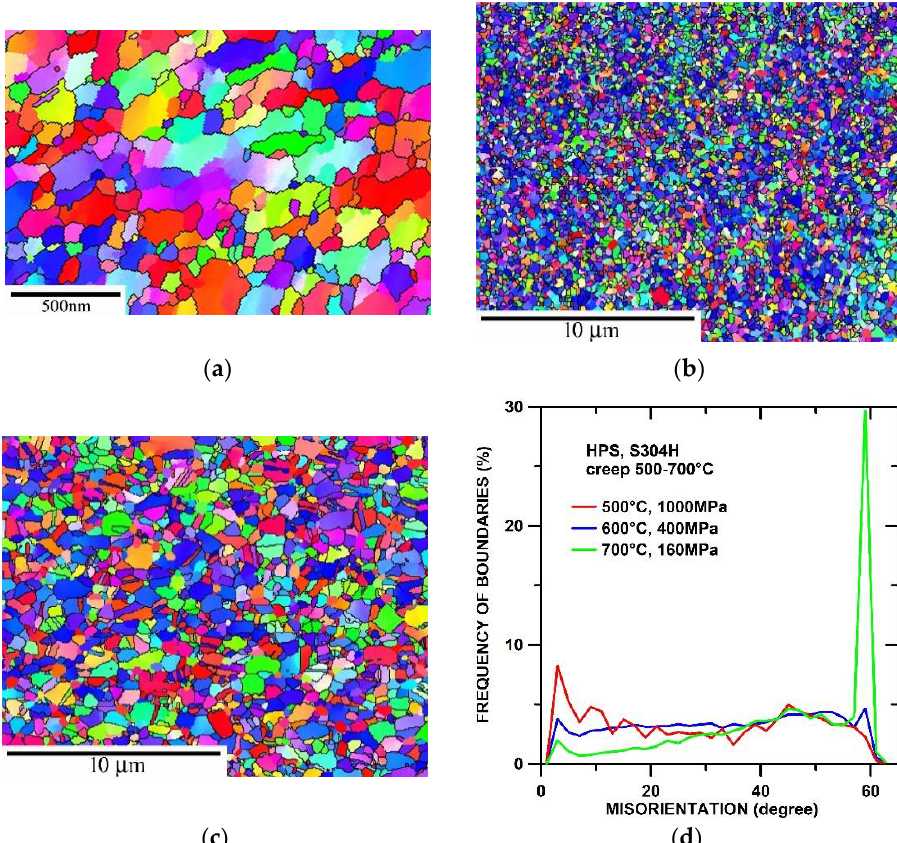
Figure 6. Microstructure of HPS-processed S304H steel observed in gauge length after creep testing at ( a ) 500 °C and 1000 MPa, ( b ) 600 °C and 400 MPa, ( c ) 700 °C and 160 MPa and ( d ) misorientation distributions measured at different testing temperatures after short-term creep.